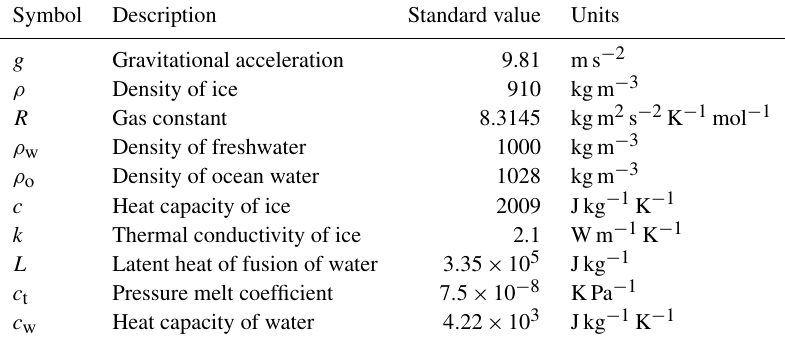
Table A1. Physical constants.